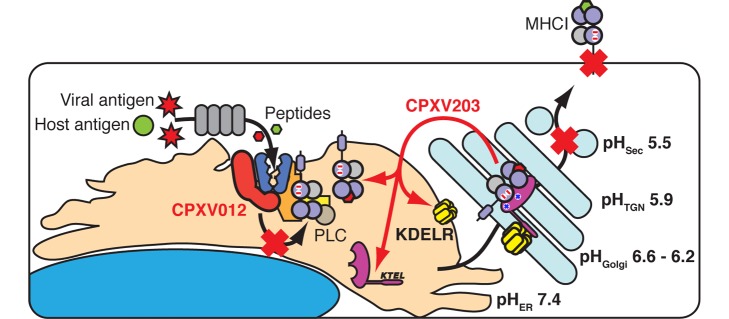
CPXV203 co-opts the KDELR to retrieve MHCI from the Golgi.Comparison of the separate but complementary strategies employed by CPXV012 and CPXV203 to downregulate MHCI. CPXV012 impairs nascent MHCI folding by inhibiting TAP, while CPXV203 selectively binds mature MHCI in the low pH environment found in the ERGIC-Golgi and then uses the KDELR to return to the ER where KDELR/CPXV203/MHCI can rapidly dissociate.